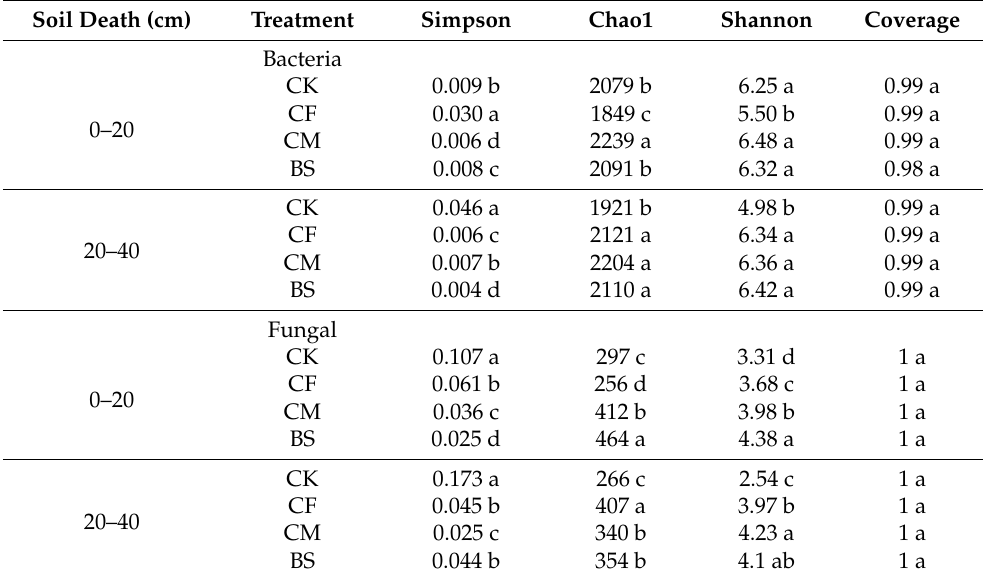
Table 6. Species diversity and abundance index at the different treatment and soil